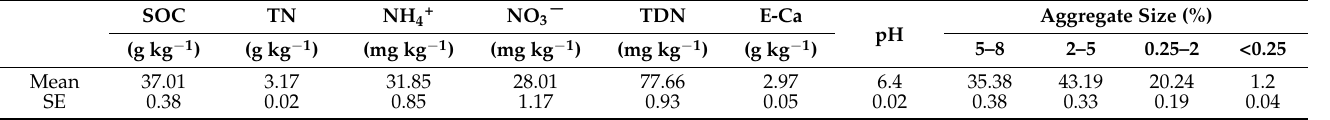
Table 1. Soil physical and chemical properties before the experiment was applied ( n =